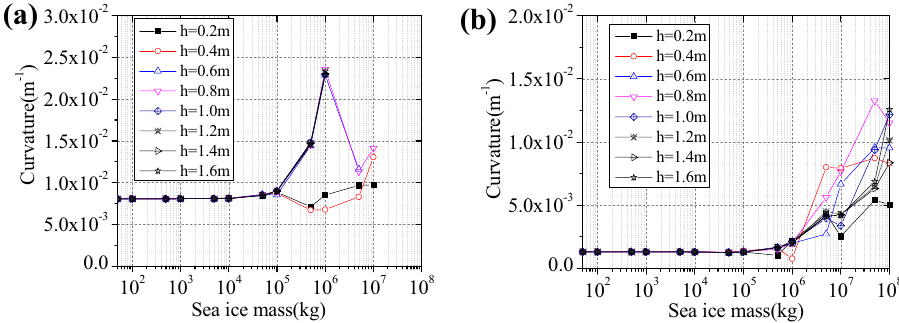
Figure 5. Maximum curvature of the tower bottom in different ice thicknesses: ( a ) T1-II-1; ( b ) T2-II-1.